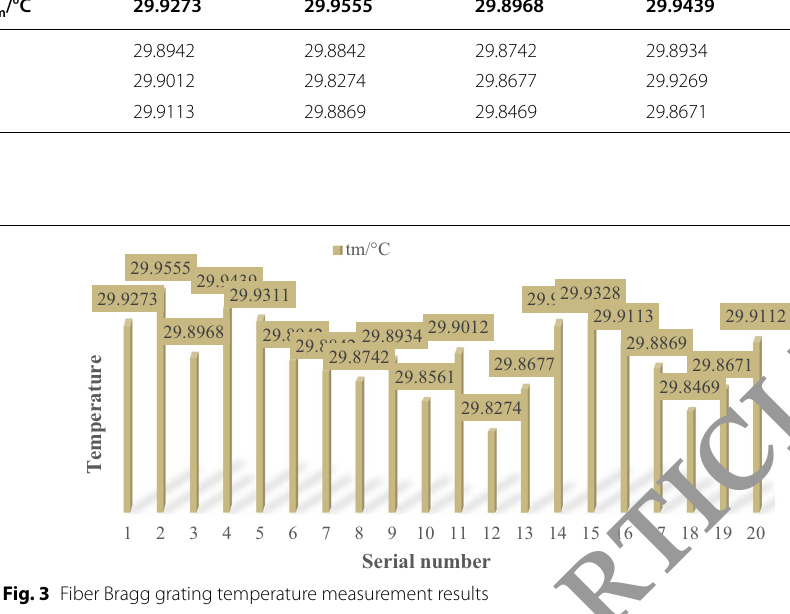
Fig. 3 Fiber Bragg grating temperature measurement